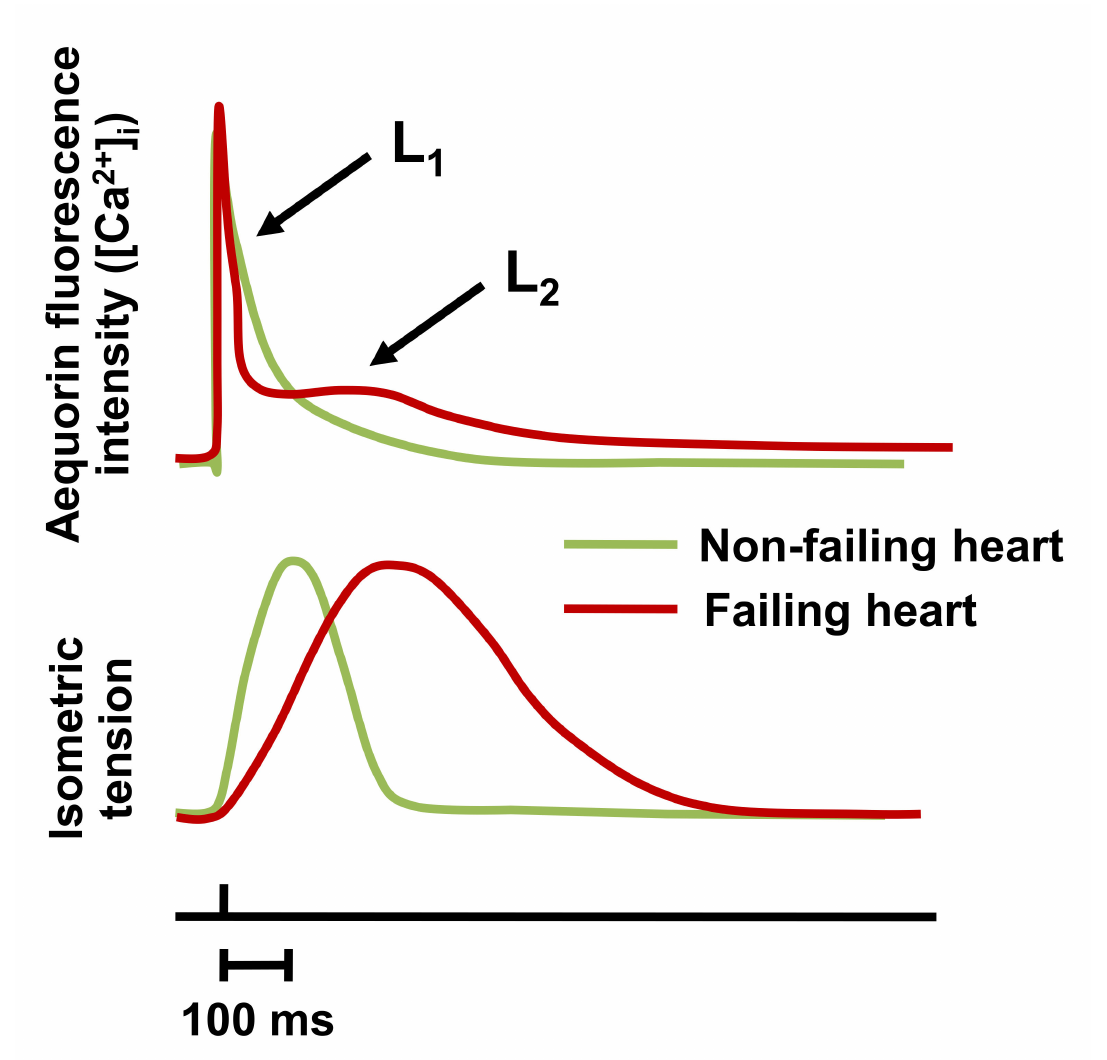
Figure 2. Calcium transients as detected with aequorin in trabeculae from non-failing (green) and failing (red) human myocardium with associated isometric contraction (green and red, respectively). L 1 is the first fast component of SR Ca 2+ release, and L 2 is the much slower Ca 2+ release and reuptake before restoring [Ca 2+ ] i to diastolic levels. Furthermore, there was a prolonged time to peak twitch force and slowed relaxation